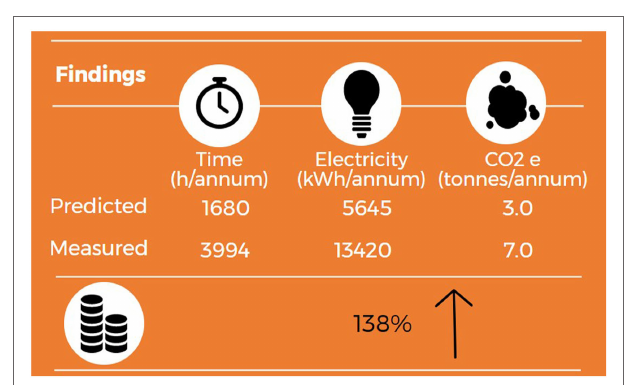
FigUre 4 | Humanities 1 CO 2 e emissions and electricity consumption